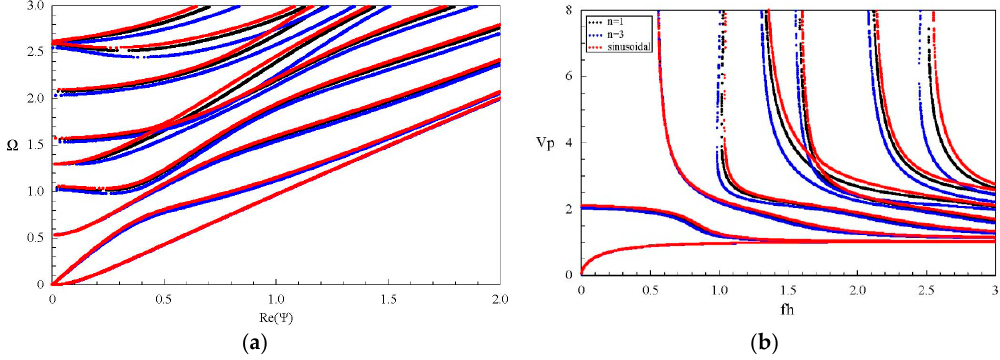
Figure 8. Dispersion curves of propagating Lamb wave for FGPPM plates with different graded fields; ( a ) Frequency spectra; ( b ) Phase velocity spectra.